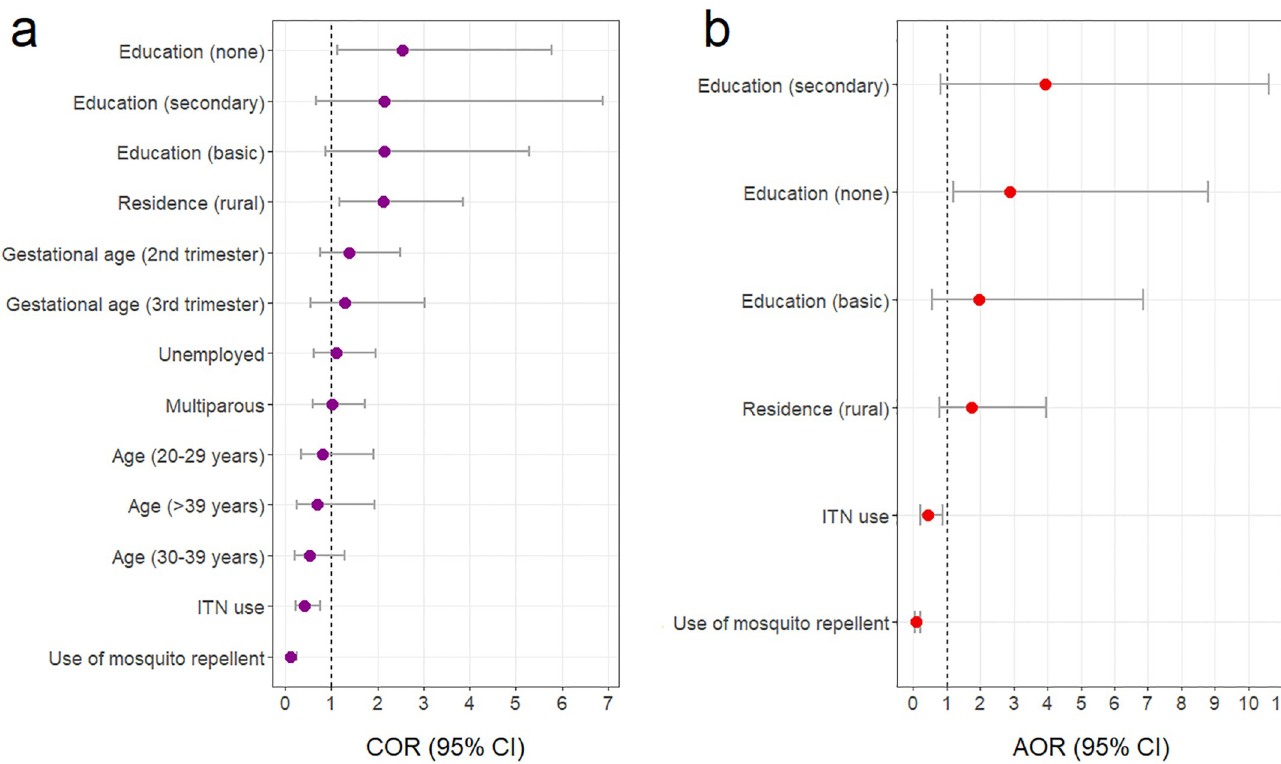
Fig 4. Crude and adjusted odds ratios for factors potentially associated with malaria. ( a ) Crude odds ratios; ( b ) adjusted odds ratios.